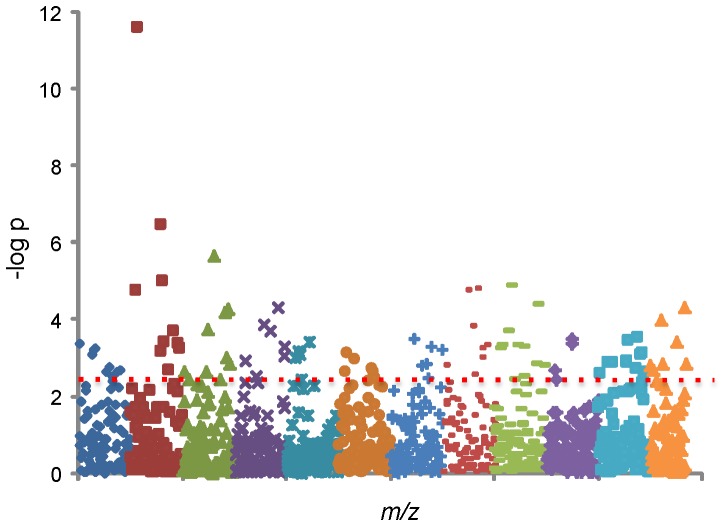
Metabolome-wide association study of NVAMD.This Manhattan plot depicts FDR analysis of 1168 m/z features comparing 26 NVAMD patients and 19 controls. The negative logp value is plotted against the m/z features. The x-axis represents the m/z of the features, ordered in increasing value from left (85) to right (850). The coloring of the symbols is arbitrary. A total of 94 features significantly differed between NVAMD and controls at an FDR of q = 0.05 (above horizontal dashed line). Two of the features shared the same m/z value but had different retention times, so the 95 features shown in this figure were collapsed to 94 in the search of m/z in the databases.